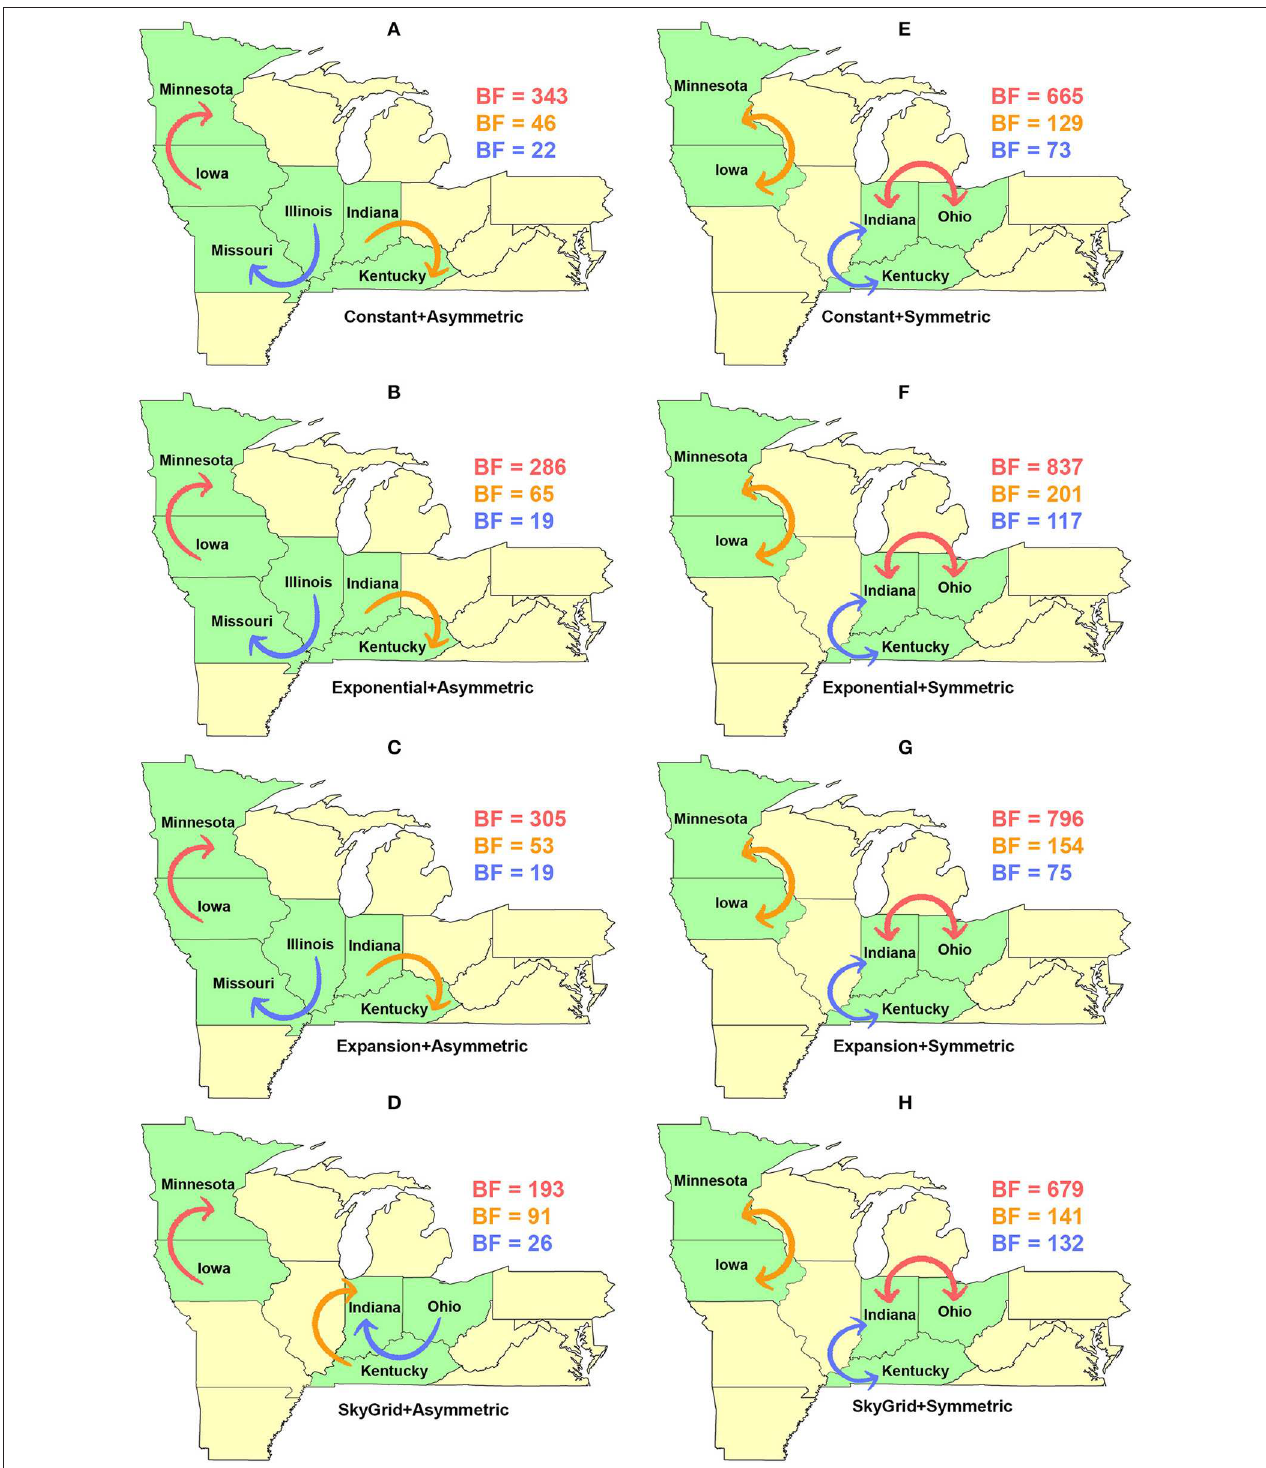
FIGURE 8 | Dispersal routes of human-like H3 swine influenza virus between states inferred from the PB2 gene segment. Dispersal routes with non-zero rates were inferred using the Bayesian stochastic search variable selection (BSSVS) approach, and statistically significant routes were selected using Bayes factors (BF). The top three dispersal routes with the strongest statistical support (by the BFs) are plotted. Arrows’ colors correspond to the color legend of their BF values on the upper right of each map. (A–D) Dispersal routes inferred from four node-age + asymmetric BSSVS priors. (E–H) Dispersal routes inferred from four node-age + symmetric BSSVS